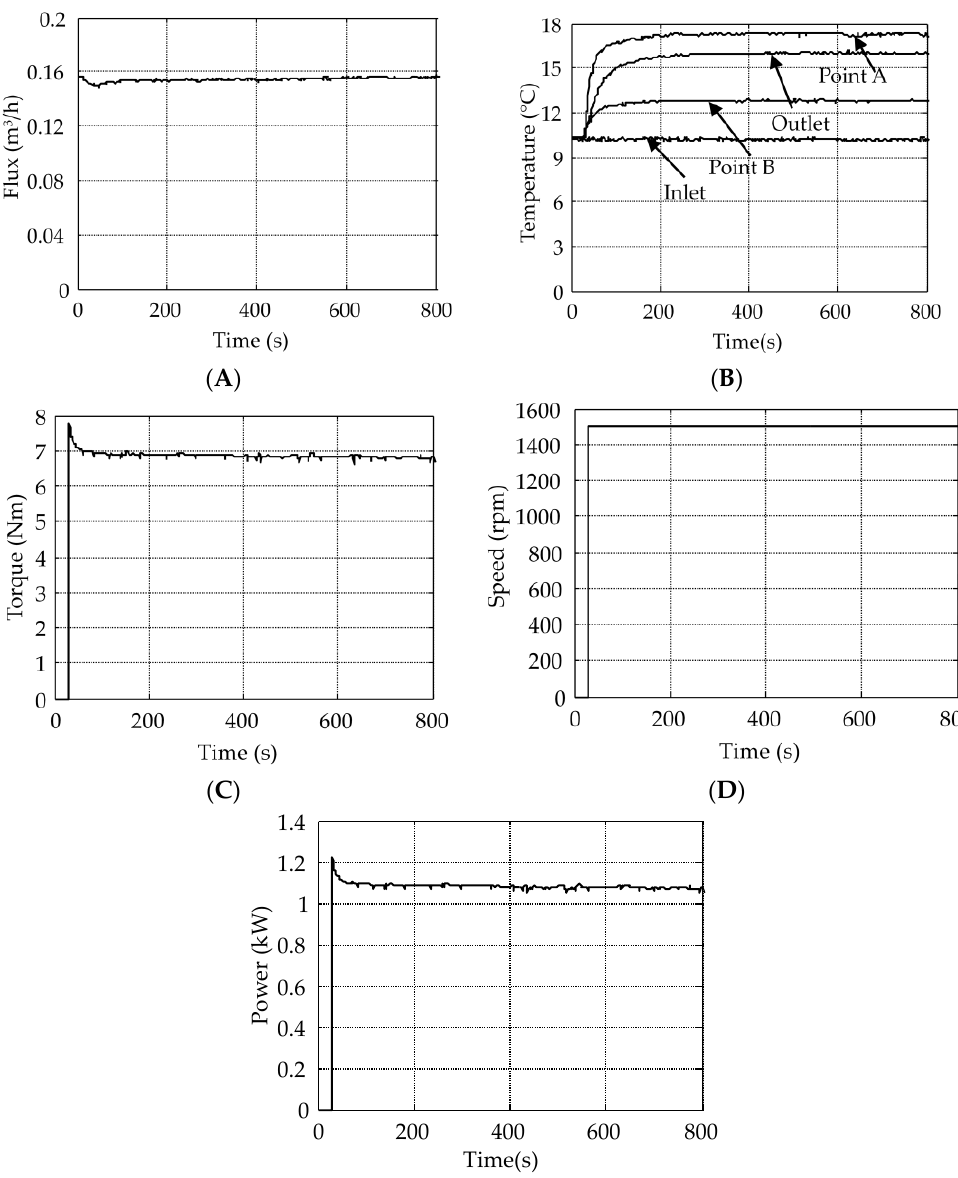
Figure 21. Measured curves: ( A ) flow flux; ( B ) temperature; ( C ) torque; ( D ) rotation speed; and ( E ) thermal power.